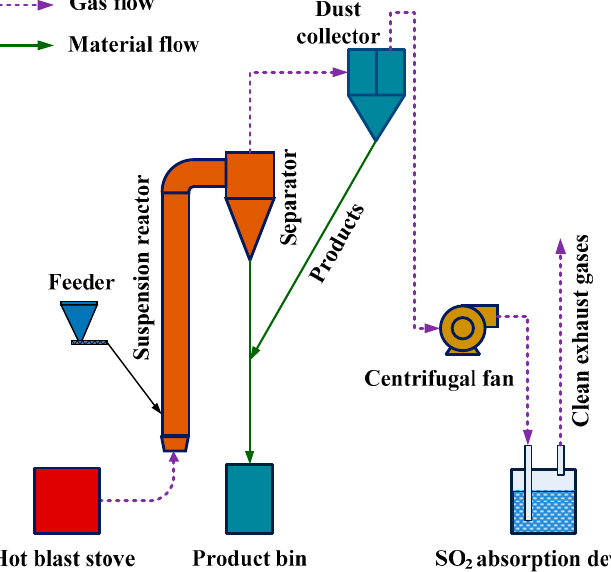
Figure 2. Overview of the system used in the conveyor-bed calcination process.